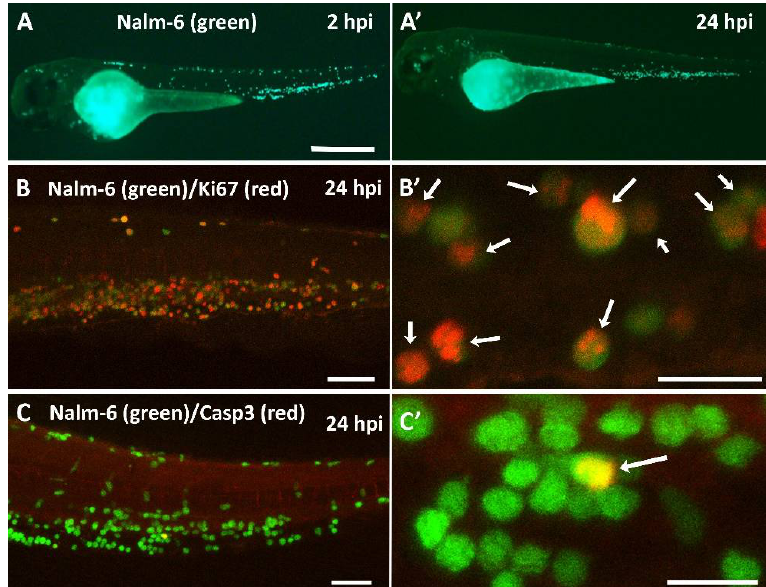
Figure 2. Nalm-6 xenografts in zebrafish embryos. GFP-expressing Nalm-6 cells (green) were injected into zebrafish embryos around 48 hours post fertilization (hpf). ( A ) An image was recorded at approximately 2 hours post injection (hpi) and again at 24 hpi ( A’ ). ( B ) Immunostaining of the tail region using an anti Ki67 antibody (red) at 24 hpi, ( B’ ) magnification of a region in B showing Ki67 positive Nalm-6 cells (arrows). ( C ) Immunostaining for apoptotic cells using an antibody against active Caspase 3 (red), ( C’ ) magnification of a region in C. The arrow indicates a cell with active Caspase 3. Images in ( A ) were recorded on a Zeiss Axio Zoom.V16 fluorescence stereo zoom microscope, and in ( B ) and ( C ) on a confocal Leica SP8 WLL microscope. Images were rendered with Adobe Photoshop CS6. The scale bar in ( A ) represents 500 µm, in ( B and C ) 75 µm, and in ( B’ and C’ ) 25 µm. Cancers 2019 , 11 , x